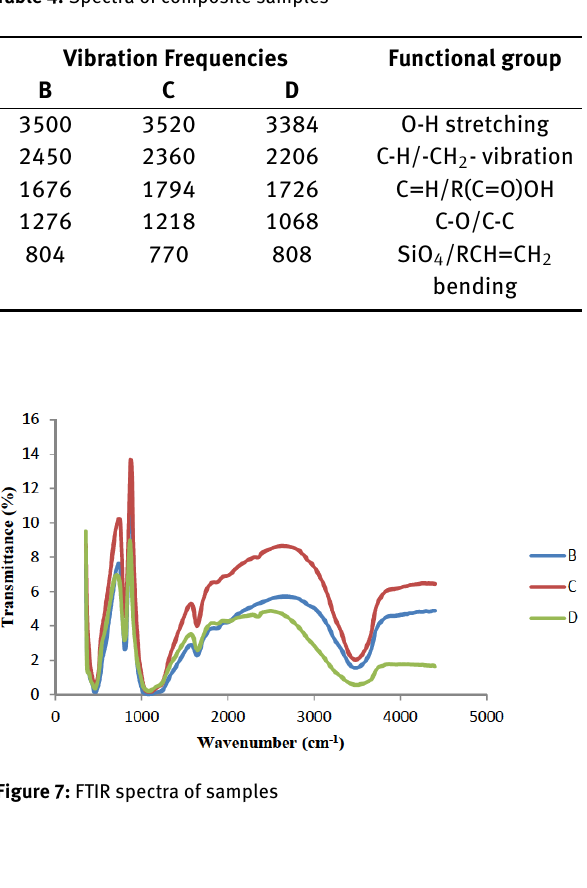
Table 4: Spectra of composite samples